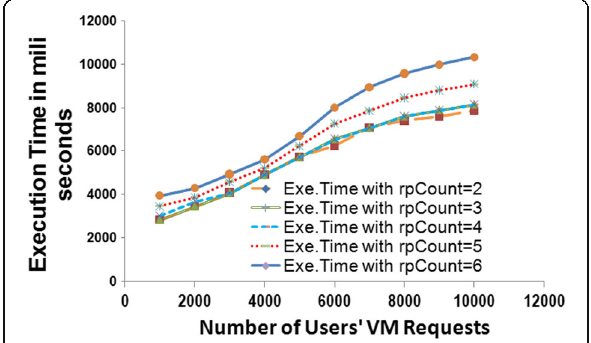
Fig. 9 Execution time of provisioned users ’ VMs request with respect to different